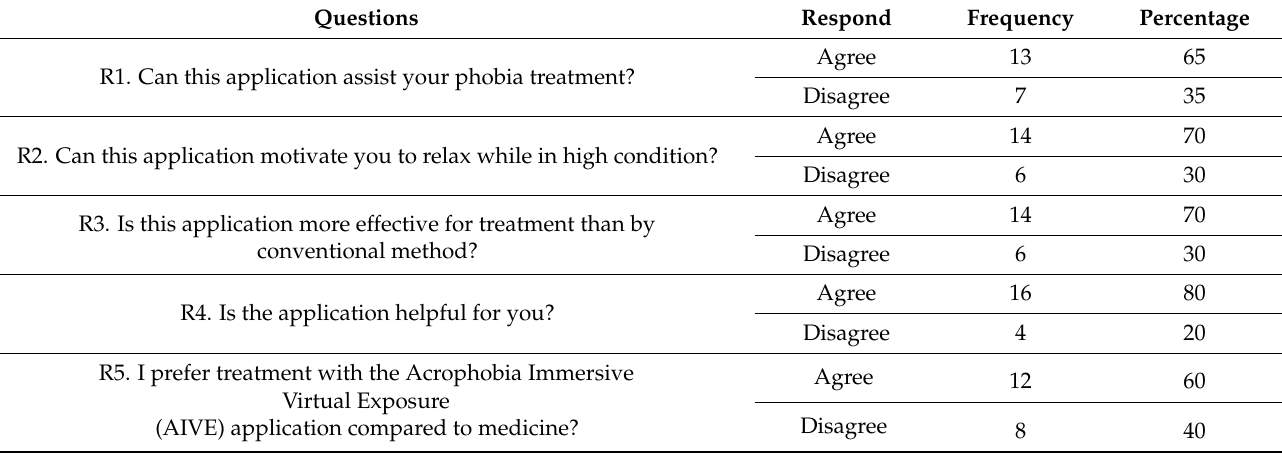
Table 1. Effects of AIVE device-based